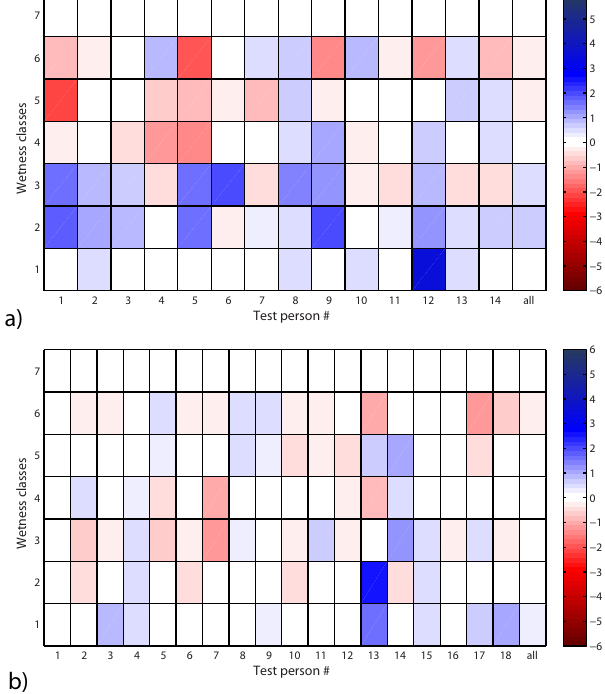
Figure 8. Mean classification difference for all sampling points of each wetness class per test person in group F all (a) tested in April; (b) tested in June. Red colors indicate mean classification to be too dry, blue colors to be too wet compared to the median of each wet- ness class. For example, test person no. 5 in panel (b) on average classified the sampling points of wetness class 3 and 4 too dry (red colors) and the sampling points of wetness class 5 and 6 too wet (blue colors) relative to the majority of classification of the other raters. However, the bright colors show, that the average classifica- tion difference was smaller than one wetness class (class 3: − 0.6, class 4: − 0.4, class 5: + 0.3, class 6: +